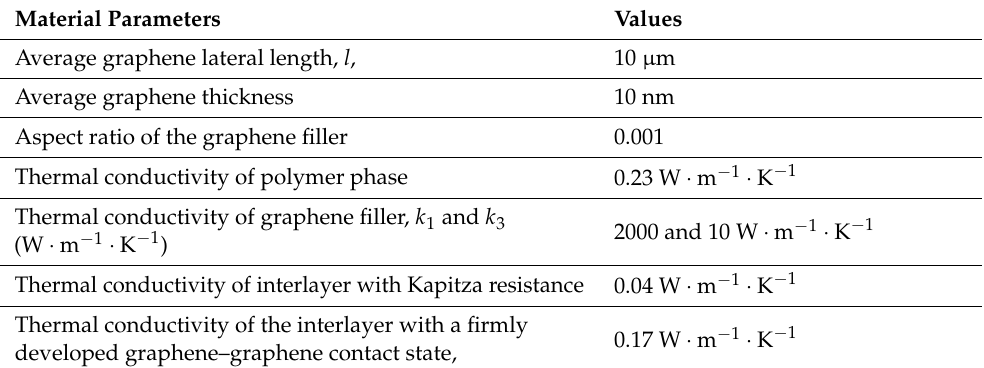
Table 2. The values of different parameters used in EMT